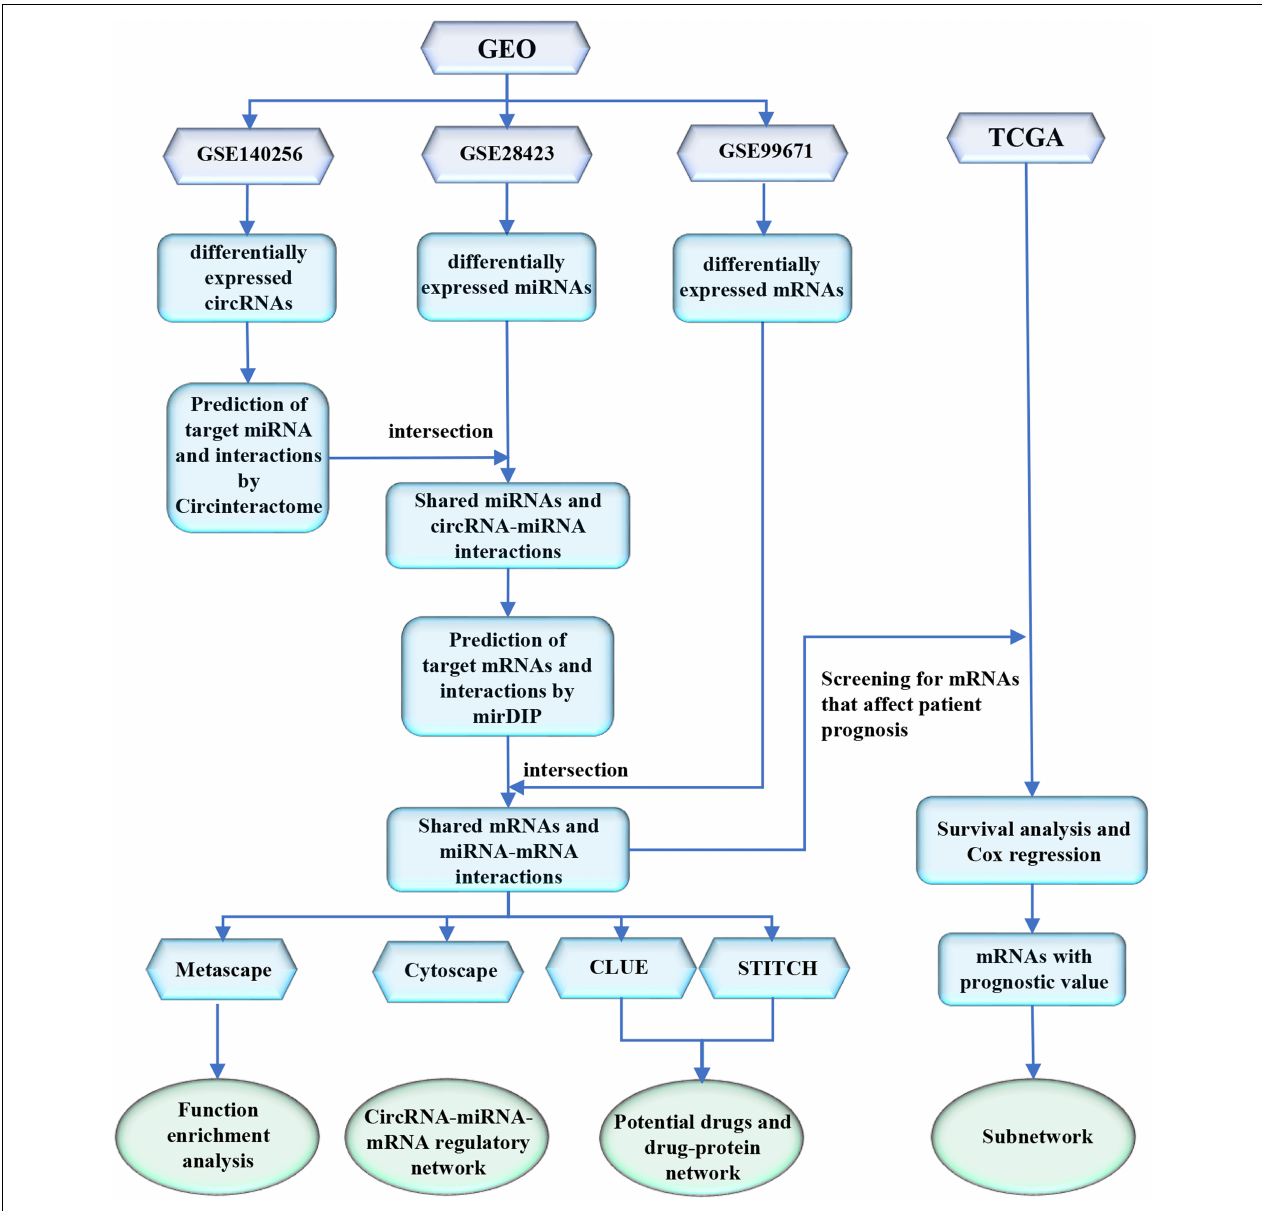
FIGURE 1 | A flow chart of the analytical